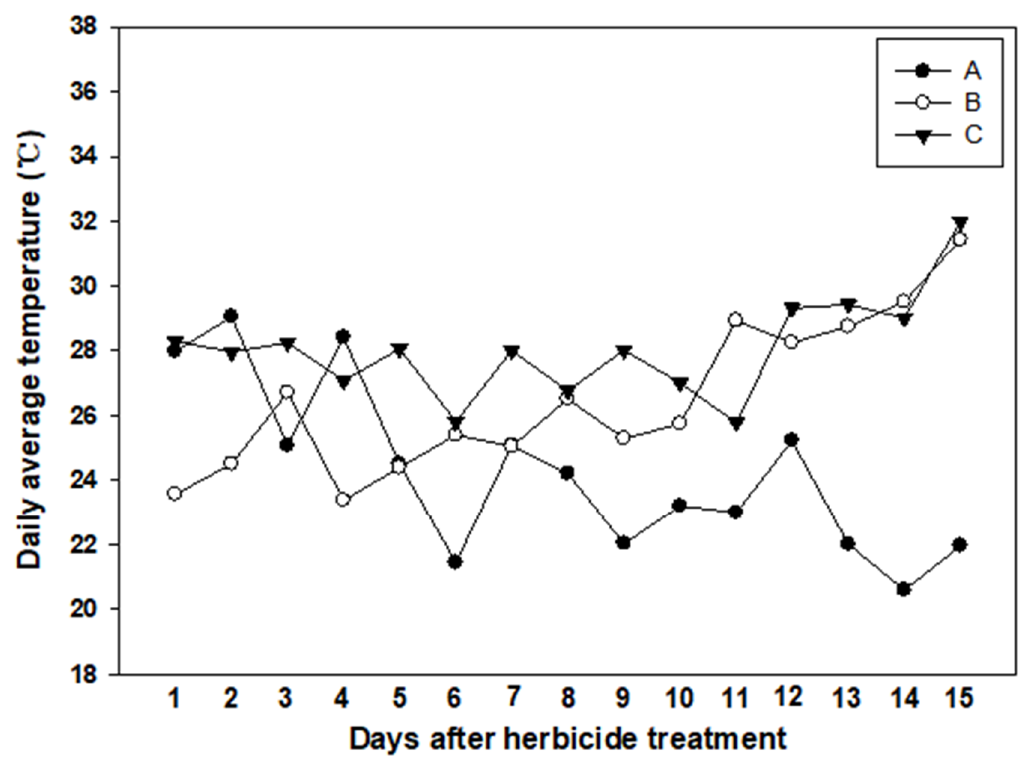
Figure 1. Daily average temperature (A, 24 °C ; B, 26 °C ; C, 28 °C ) on days after herbicide treatments in the greenhouse.